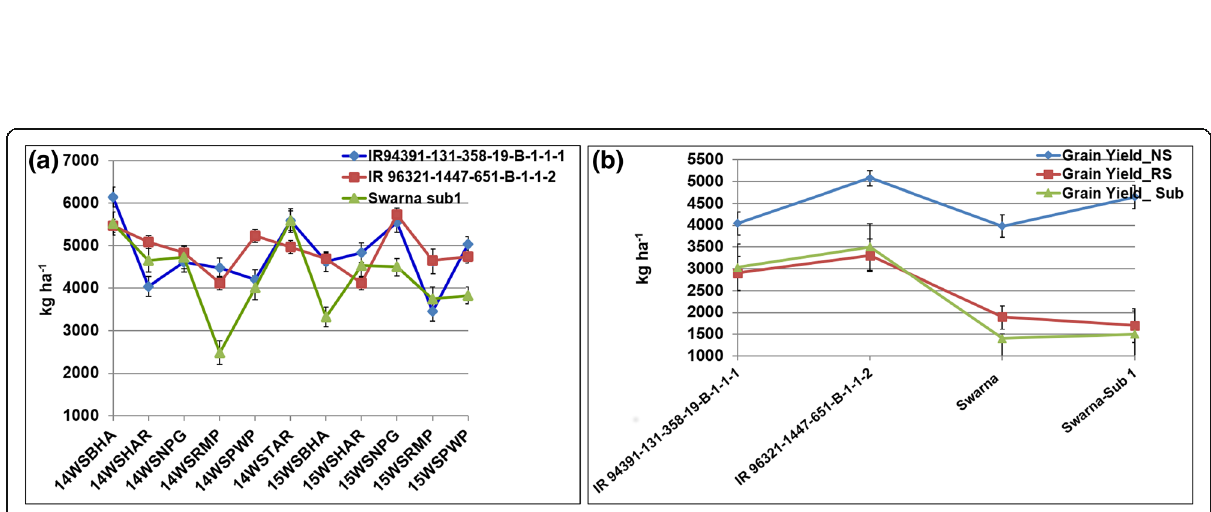
Fig. 4 The mean grain yield performance of NILs in comparison with ( a ) Swarna-Sub1 across multilocational trials in Nepal under NS; b Swarna and Swarna-Sub1 in 2015WS at Hardinath under NS, RS and submergence conditions. BHA: Bhairahawa; HAR: Hardinath; NPG: Nepalgunj; RMP: Rampur; PWP: Parwanipur; TAR: Tarahara NS: non-stress, RS: reproductive stage drought stress, Sub: